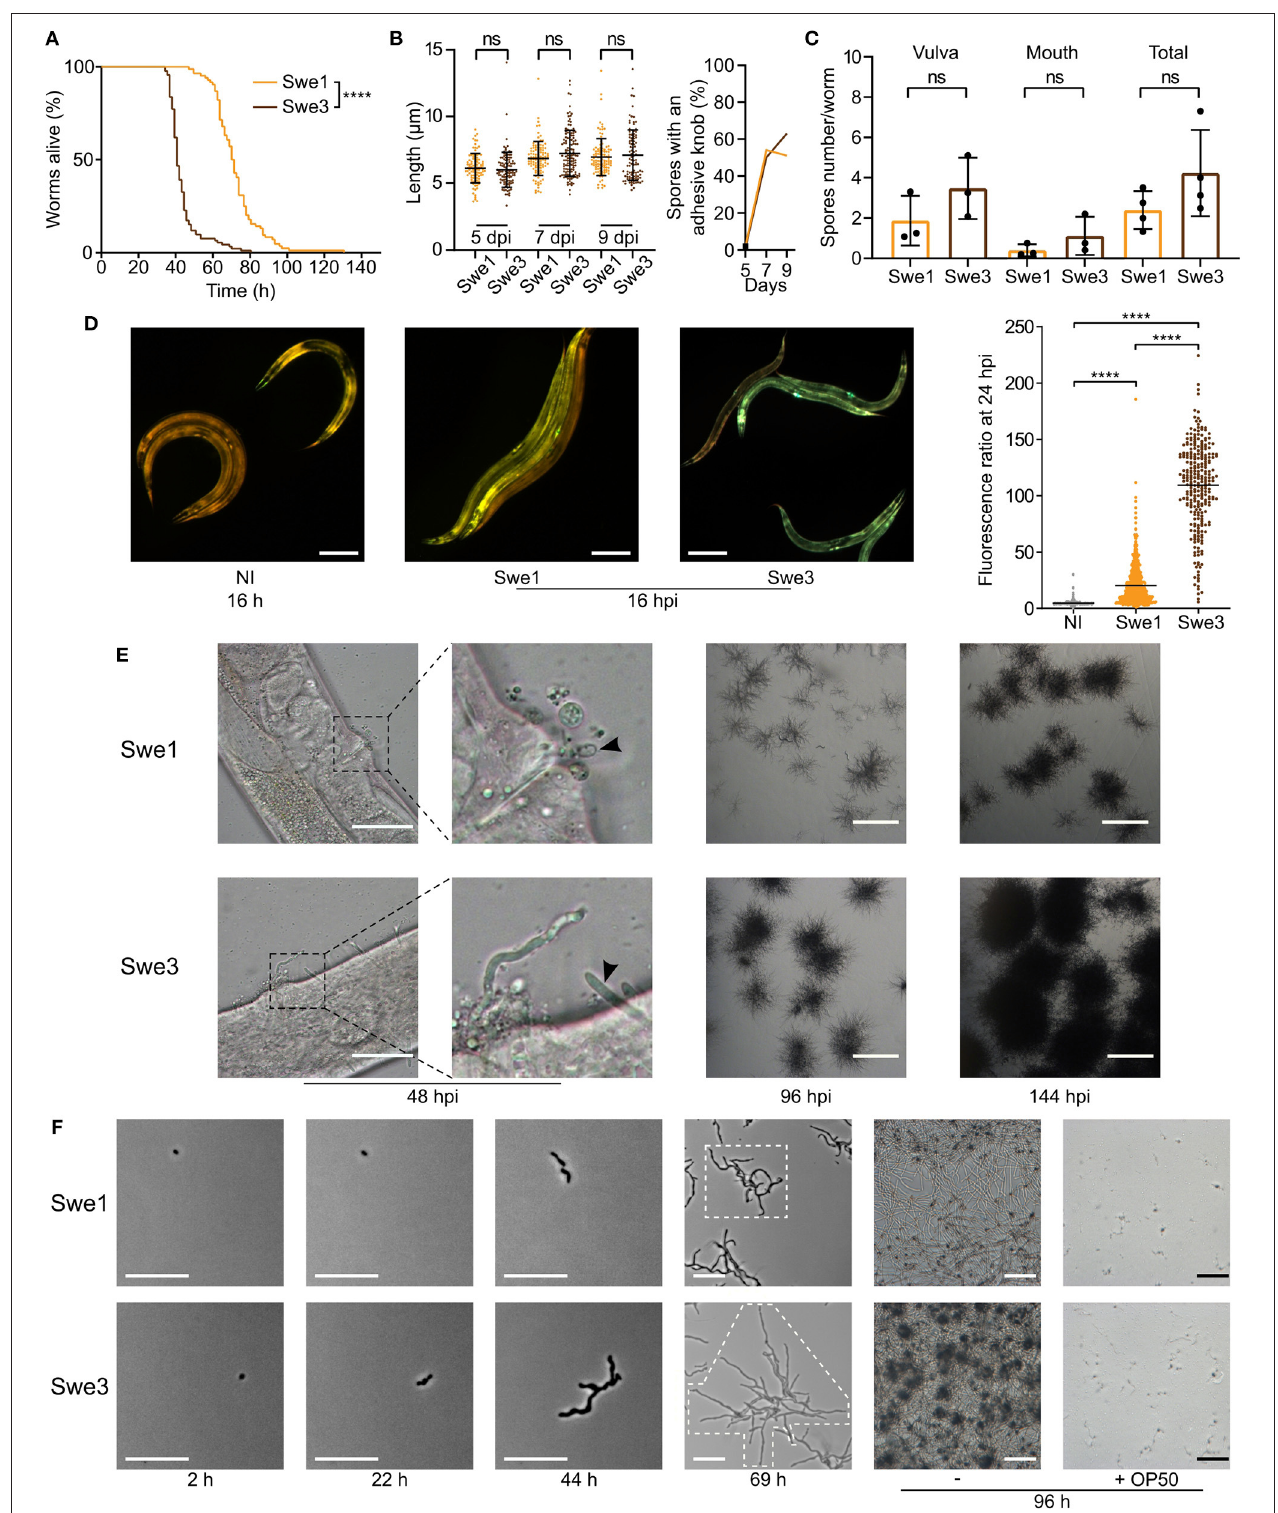
FIGURE 1 | Phenotypic differences between Swe1 and Swe3. (A) Survival of C. elegans worms (strain IG463) following infection at 25 ◦ C with 1 × 10 9 spores of Swe1 or Swe3; n = 100 for each strain, **** p < 0.0001, one-sided log rank test. The results are representative of three independent trials. (B) Comparison of the size